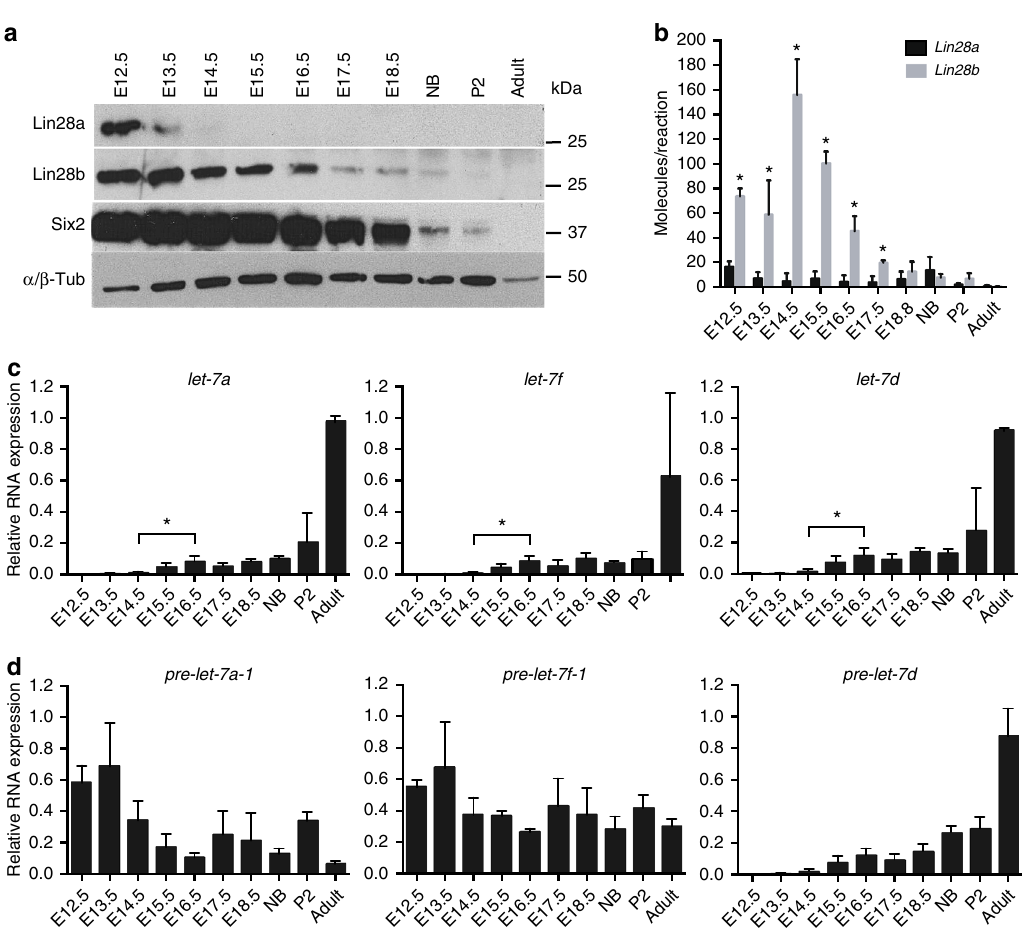
Fig. 1 Expression of Lin28 and let-7 in mouse embryonic kidney. a Western blot analysis against Lin28a, Lin28b, Six2, and α / β -Tubulin proteins in lysates collected from dissected embryonic day 12.5 – 18.5 (E12.5 – E18.5), newborn (NB), postnatal day 2 (P2), and adult wild-type kidneys. b Absolute qRT-PCR analysis measuring the levels of Lin28a and Lin28b mRNAs in wild-type kidneys. n = 3 for each sample type. c , d Relative qRT – PCR analysis measuring the levels of mature and precursor (pre-) let-7 miRNAs in wild-type kidneys. n = 3 – 5 for each sample type. Error bars represent mean ± SD. (*) = p < 0.05, unpaired, two-tailed Student ’ s t